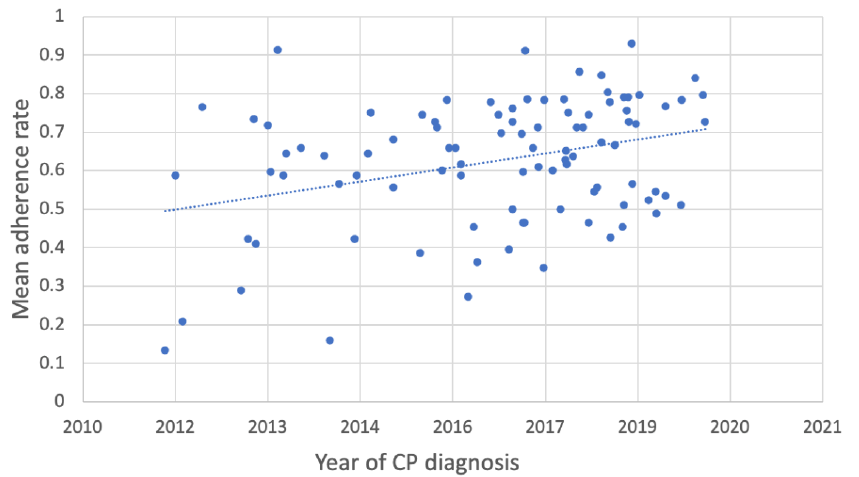
Figure 2. Linear regression of mean adherence rate in relation to date of diagnosis. X-axis represents the date of diagnosis, and the mean adherence rate is given on the y-axis ( p = 0.002). Table 4. Number of patients who were not followed up in the last 12 months, possible cause, and date of last visit.